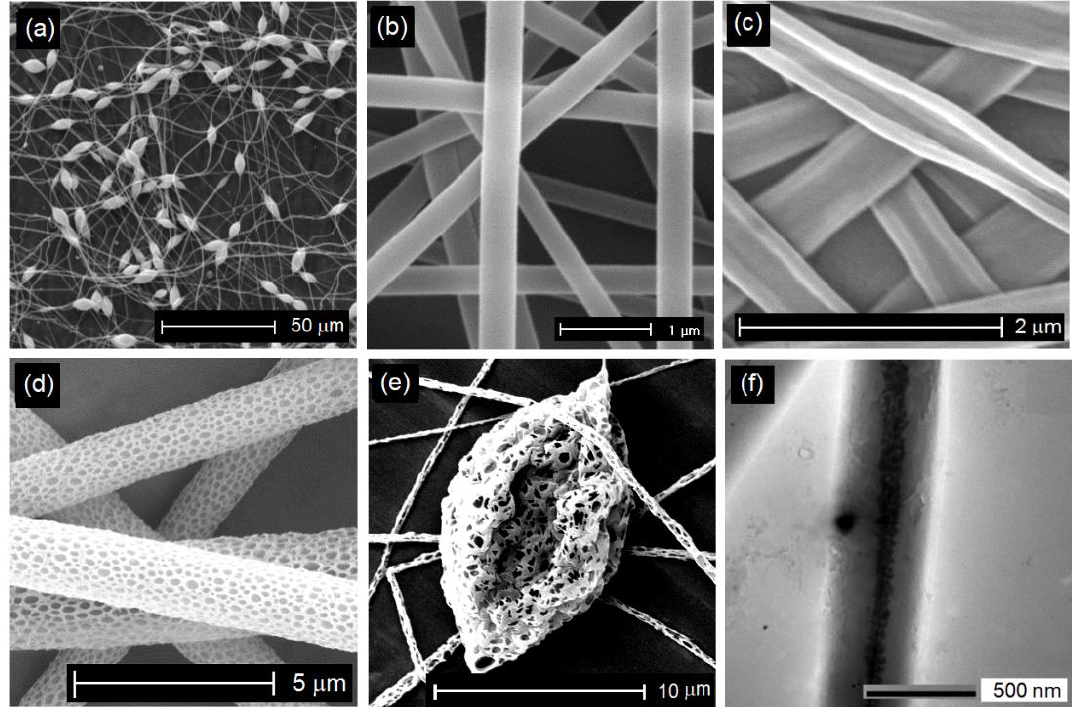
Figure 6. Different morphologies of PLA fibers are obtained by tuning the electrospinning parameters: ( a ) bead-on-string morphology (unpublished original picture by the authors), ( b ) cylindrical shape with a smooth surface (reproduced from an open access paper [4] distributed under the